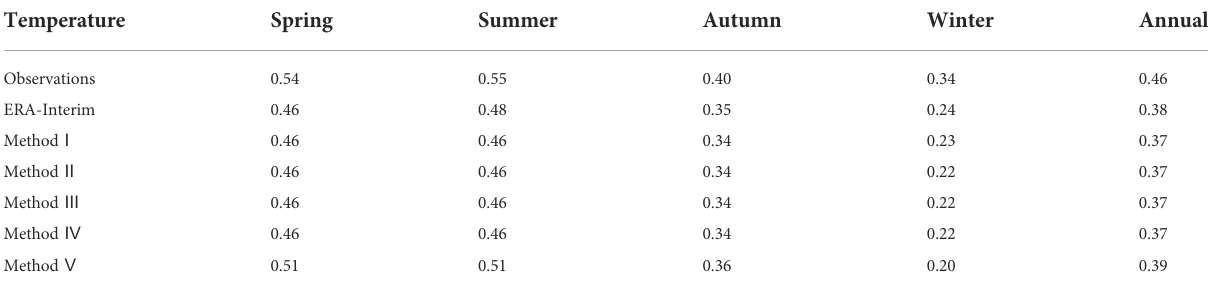
TABLE 8 Seasonal warming trends ( ° C/decade) observed, original ERA-Interim temperature, and temperatures corrected with fi ve methods for the period 1979-2017 in the QLM. Temperature